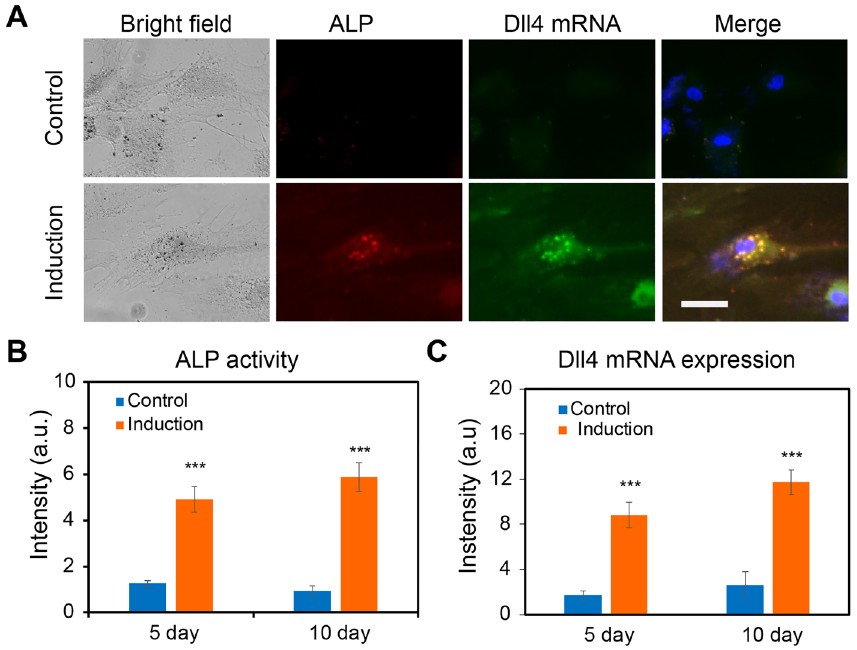
Figure 4. Dll4 mRNA is a molecular signature of hMSCs differentiation. ( A ) Representative bright filed and fluorescent images of single hMSCs under control and induction groups after 5 days. Green: Dll4 mRNA; red: ALP activity; blue: nucleus. Control group: cells were cultured and maintained in the basal medium. Induction group: cells were cultured in basal medium and induced by osteogenic induction medium after 2 days of cell seeding. Images are representative of at least three independent experiments. ( B , C ) Mean fluorescent intensity of ALP activity and Dll4 mRNA expression after 5 days and 10 days of hMSCs osteogenic induction. ALP activity ( B ) and Dll4 expression ( C ) comparison in the control and induction groups, respectively. Data represent over 100 cells in each group and are expressed as mean ± s.e.m. (n = 4, *** p < 0.001, ** p < 0.01). Scale bar: 50